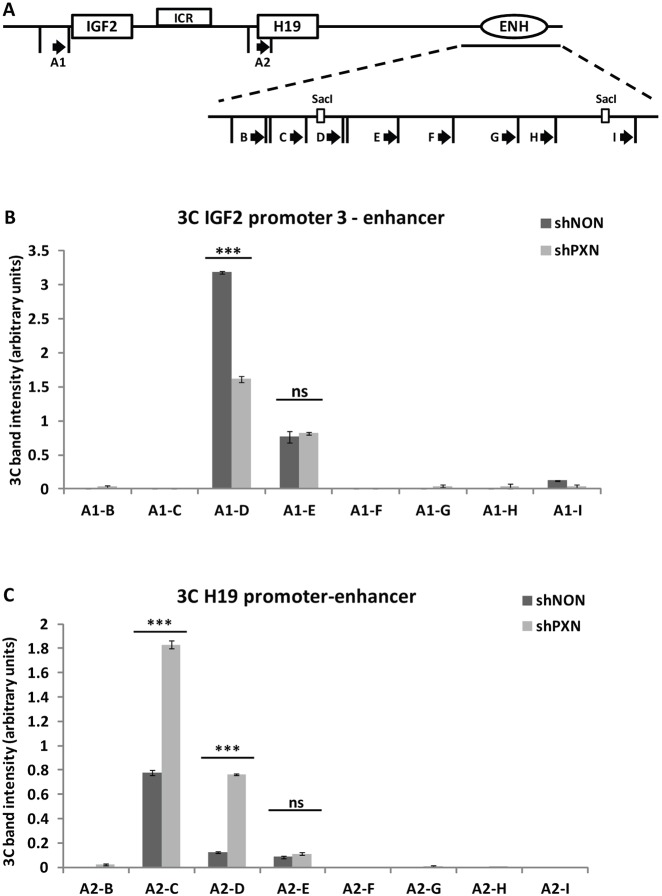
Paxillin regulates the interactions between the IGF2 P3 or H19 promoter and the enhancer. (A) Design of 3C analysis. Vertical lines show PstI restriction sites and black arrows represent the designed primers. (B) A chromatin conformation capture (3C) assay was performed using the IGF2 P3 fragment (A1) as an anchor, and the interaction between the IGF2 P3 fragment and fragments of enhancer (A1-B–A1-I) in HepG2 cells was assessed. The interaction frequency between IGF2 P3 and the enhancer was significantly lower after paxillin knockdown (shPXN) compared to control (shNON). (C) A 3C assay was performed in the same way, but using the H19 promoter fragment (A2) as an anchor examining the interaction between the H19 promoter and the fragments of enhancer (A1-B–A1-I). Paxillin depletion increased the interaction frequency between H19 promoter and the enhancer. The interaction frequency corresponds to the intensity of amplified PCR products; analyzed gels are shown in supplementary material Fig. S2. Data are shown as mean±s.d. (n≥3). ***P<0.001; ns, not significant (Student's t-test).